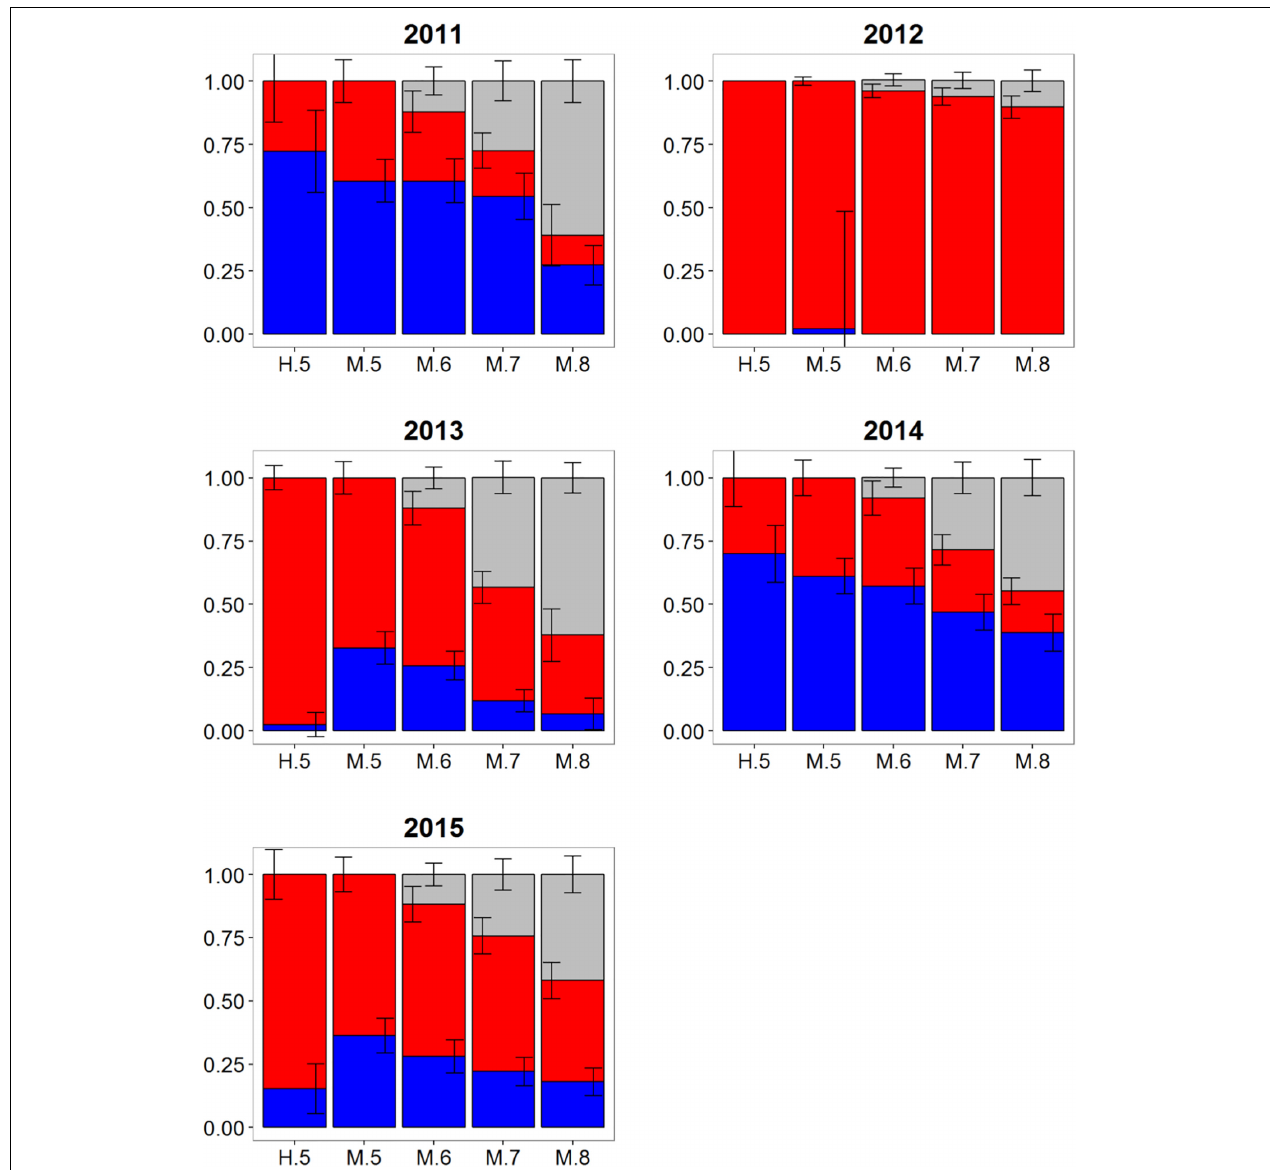
FIGURE 5 | Estimated proportions of western (blue), eastern (red), and undetermined (gray) Atlantic bluefin tuna in samples collected from 2011 to 2015 off Morocco. Results are based on mixed-population analysis using HISEA and multinomial logistic regression (MLR) frameworks. H.5 denotes predictions from HISEA while MLR estimates are shown as M.5, M.6, M.7, M.8 to represent the four different probability thresholds (0.5–0.8). Uncertainty around predictions shown with error bars which represent 1 ± SD around estimated